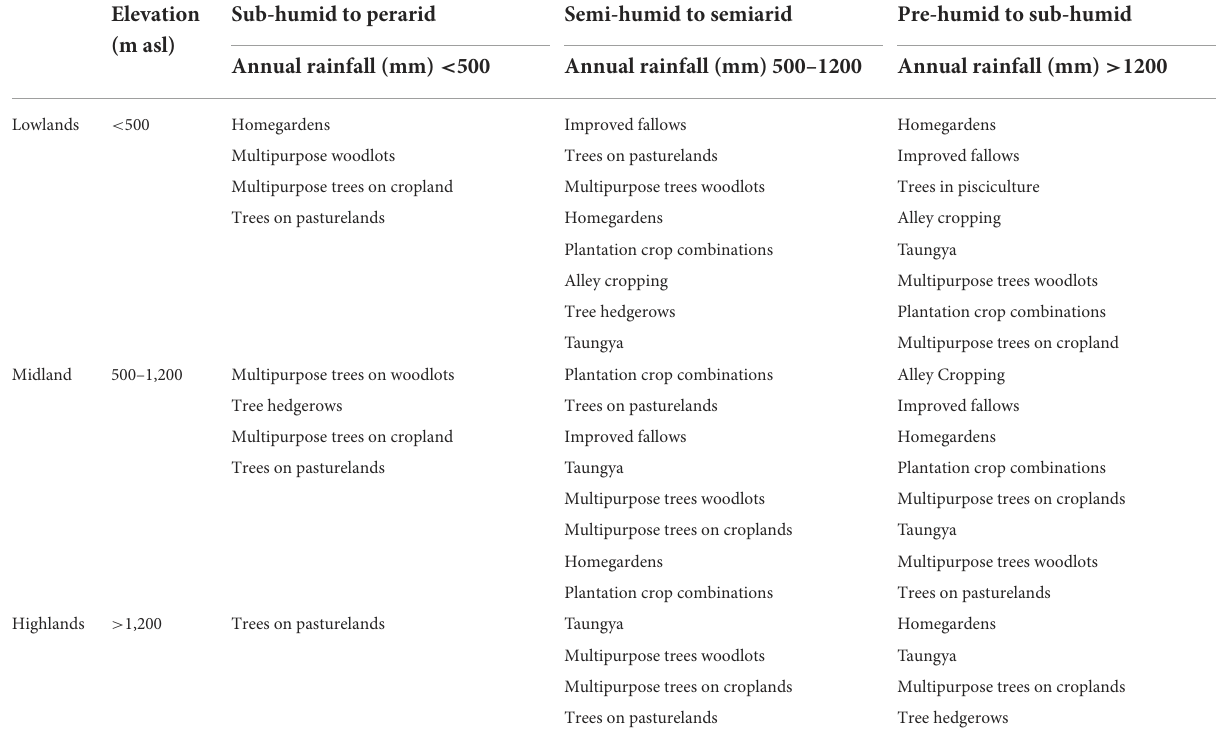
TABLE 1 Spread of the main types of tropical agroforestry systems based on supporting ecological